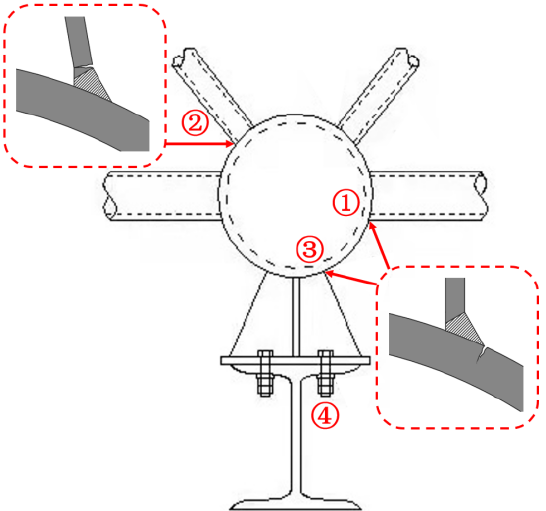
Figure 1. Schematic diagram of fatigue failure location. ( ① ) Spherical surface of the steel pipe connections; ( ② ) Pipe surface of the steel pipe connection; ( ③ ) Spherical surface of the cross-plate connection; ( ④ ) High-strength bolts.